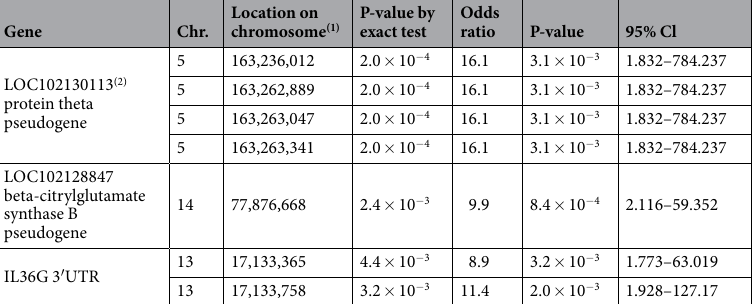
Location on chromosome (1)